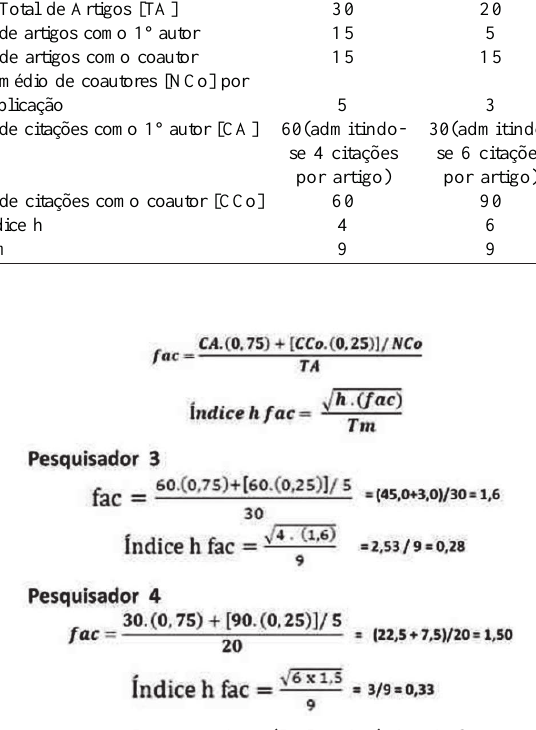
Fig 2 - Desenvolvimento dos cálculos de índice h-fac para os pesquisadores 3 e